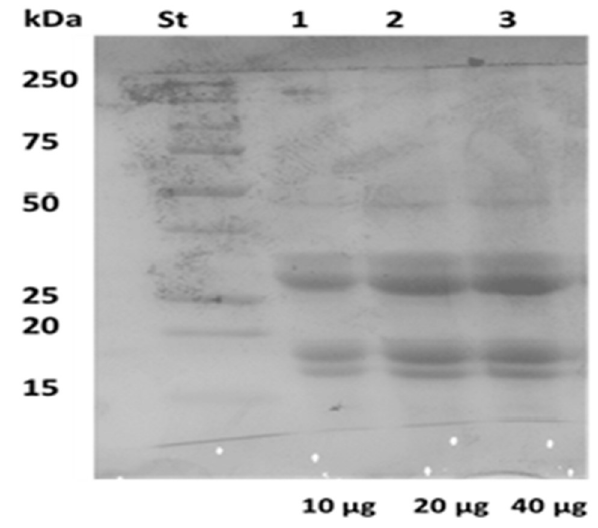
Figure 1. SDS-PAGE (12%) profile of different amounts of argan seed protein concentrate (ASPC).